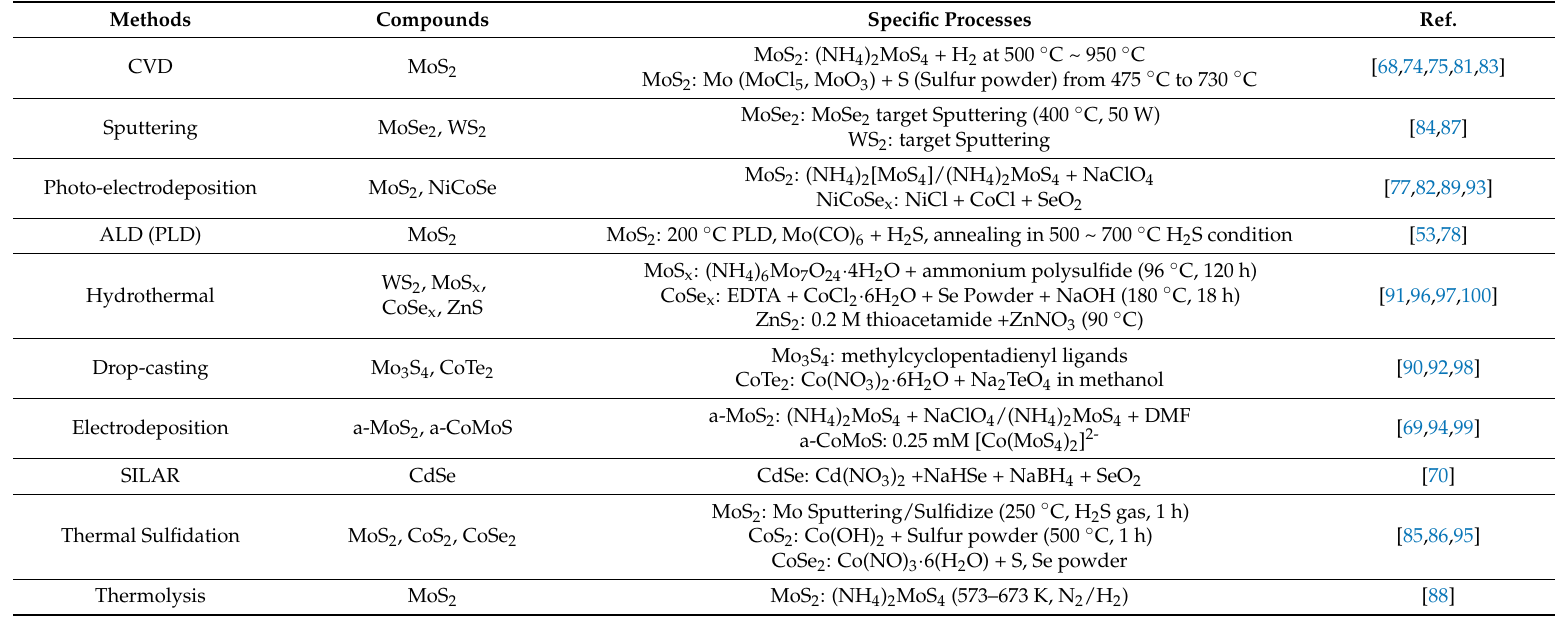
Table 2. Various synthesis routes of TM(D)Cs on Si